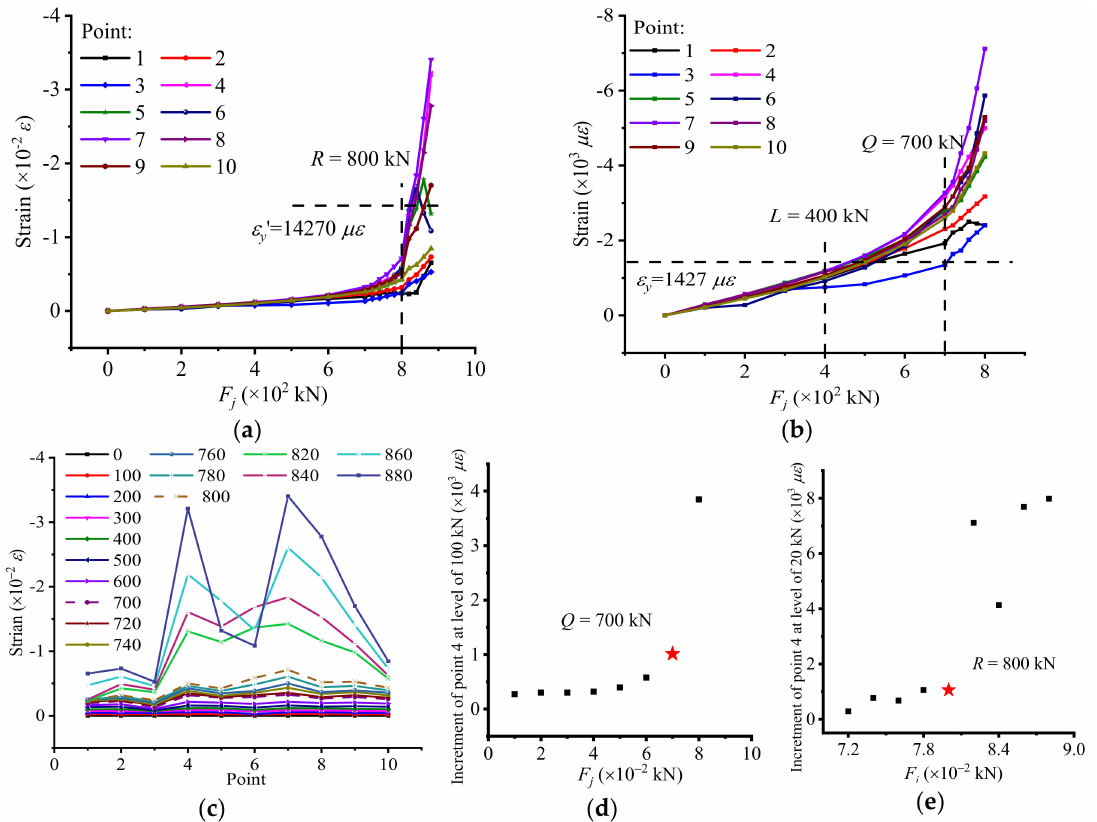
Figure 7. The changing characteristics of strain-based stressing state modes: ( a ) The trend changing characteristics of strain-based stressing state modes during the whole loading process; ( b ) the trend changing characteristics of strain-based stressing state modes between 0 kN and 800 kN; ( c ) the distribution pattern changing characteristics of strain-based stressing state modes; ( d ) the increment changing characteristics of point 4 at level of 100 kN; ( e ) the increment changing characteristics of point 4 at level of 20